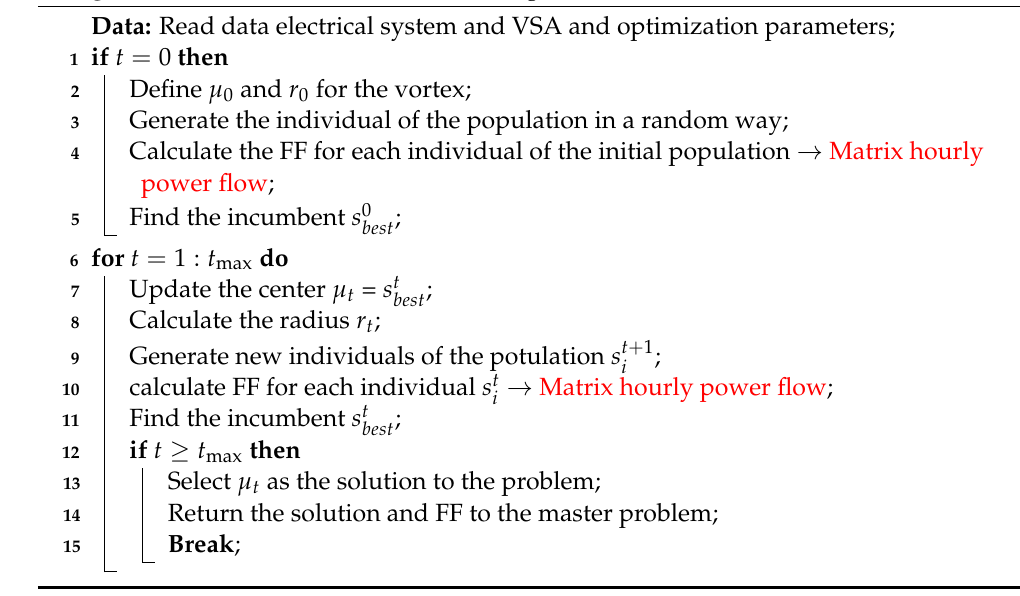
Algorithm 1: Pseudocode vortex search